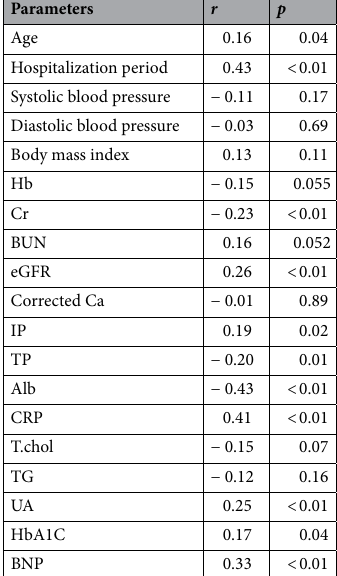
Table 2. Correlation between mean CFS scores obtained by subjective assessment and objective parameters.